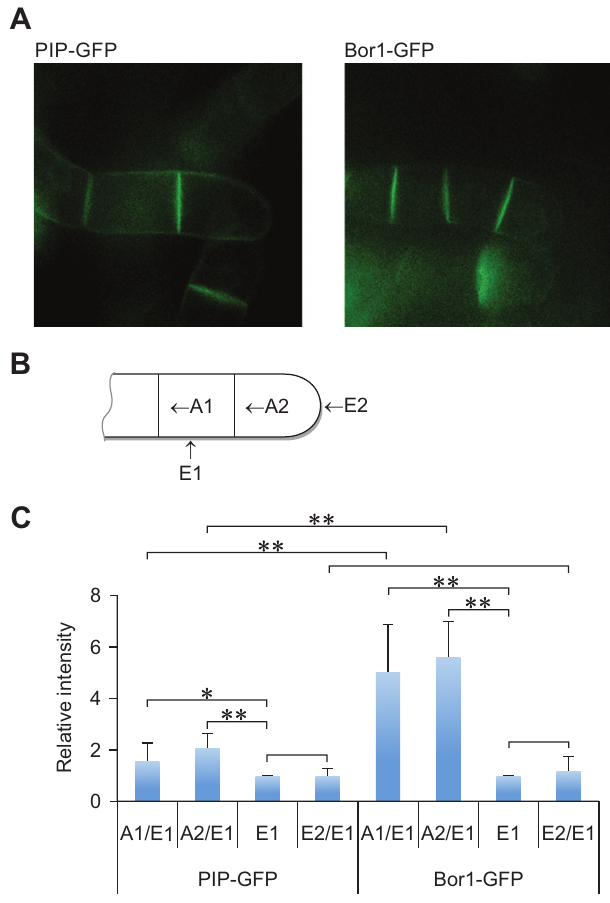
Figure 4. Polarized localization of BOR1-GFP in tobacco BY-2 cells. A . Confocal images of PIP-GFP and BOR1-GFP at the four- cell stage. About half to two-thirds of cell clumps are shown. GFP fluourescence of PIP-FGP at the plasma membrane that faces to the medium showed much higher intensities than that of BOR1-GFP. B . Schematic representation of each cell membrane face in the cell clump. Only half of the 4-cell stage cell clump was indicated. A1, A2, E1 and E2 indicate the face of cells defined for the analysis of polarized localization. C . Comparison of the relative density of fluorescence at each face of PIP-GFP and BOR1-GFP expressing cells. Means (with SD) density relative to the E1 face (n=8) are